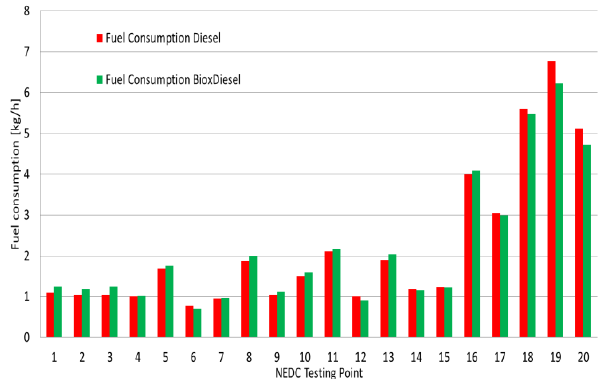
Fig. 5. Comparison of the fuel consumption for the engine fed with Bi- oxdiesel and Diesel fuel for selected operation points according to NEDC procedure